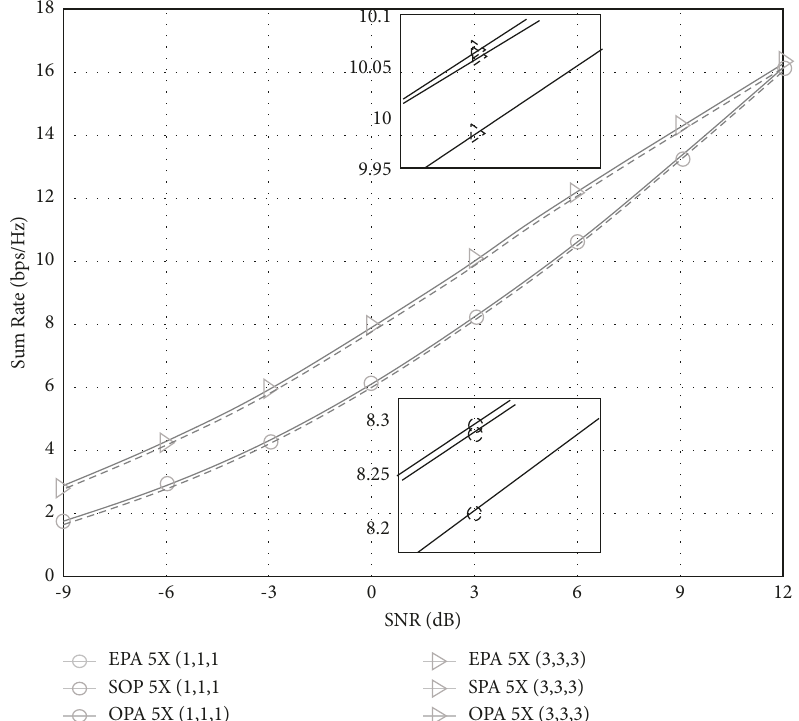
Figure 5: Total and partial transfer rates of EPA, SPA, and OPA under 5X (3, 3, 3) and 5x(1, 1, 1) system configurations.